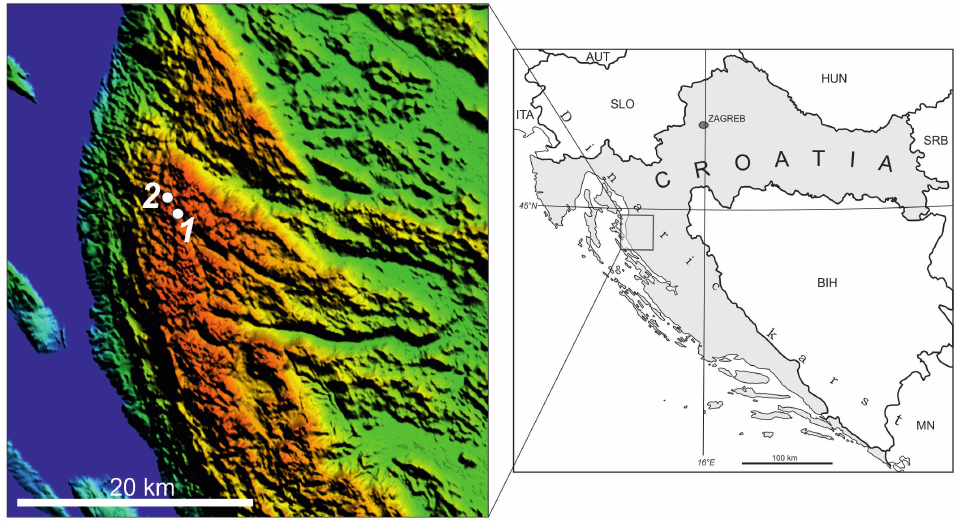
Fig. 1. Location of the Vukuši´c Ice Cave (1) and the Zavižan meteorological station (2). Gray shading in the map shows the territory of Croatia.